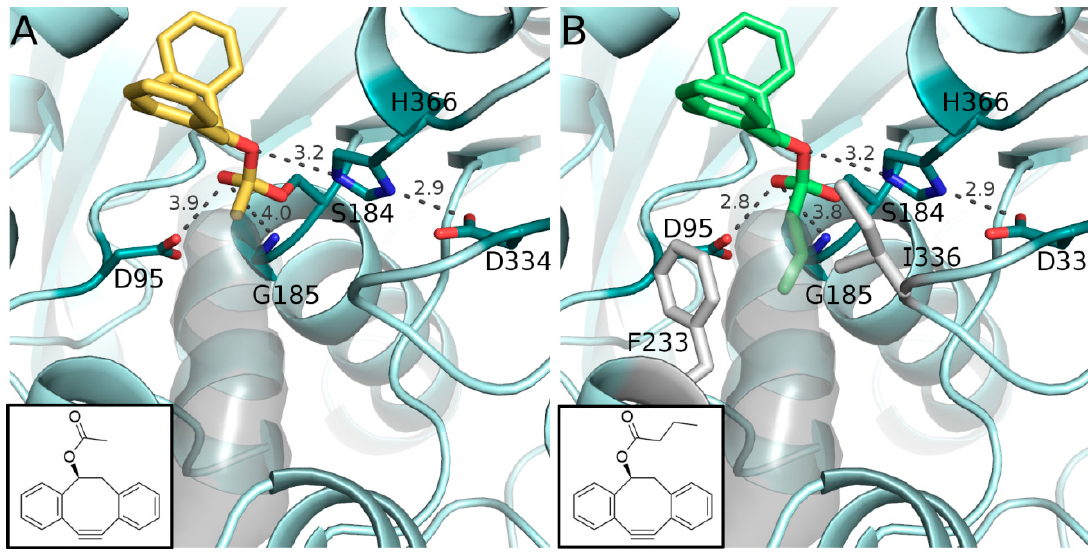
Figure 3. Predicted binding mode of DIBO to CAL-A. The docked complexes represent the second acyl-enzyme intermediates (D, Scheme 2) and indicate that both acetylated (yellow sticks, ( A )) and butanoylated DIBO (green sticks, ( B )) can bind to the catalytic amino acids and the amino acids of the oxyanion hole (dark turquoise sticks). However, besides these hydrogen bonds, butanoylated DIBO can interact with residues F233 and I336 (gray sticks), which are located within 4 Å distance from the hydrocarbon chain of the propyl group. These hydrophobic interactions likely increase the binding affinity, causing the slower release of the product. 2D structures of the two DIBO structures are included as inserts.